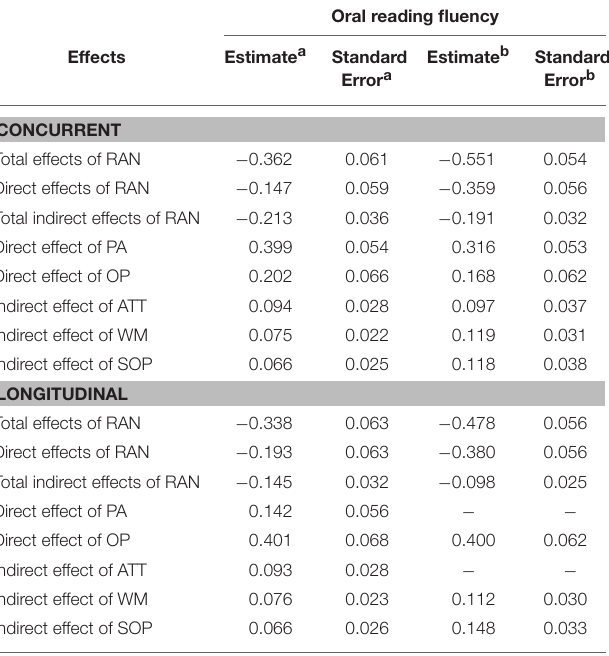
TABLE 4 | Total, Direct, and Indirect Effects of RAN on oral reading